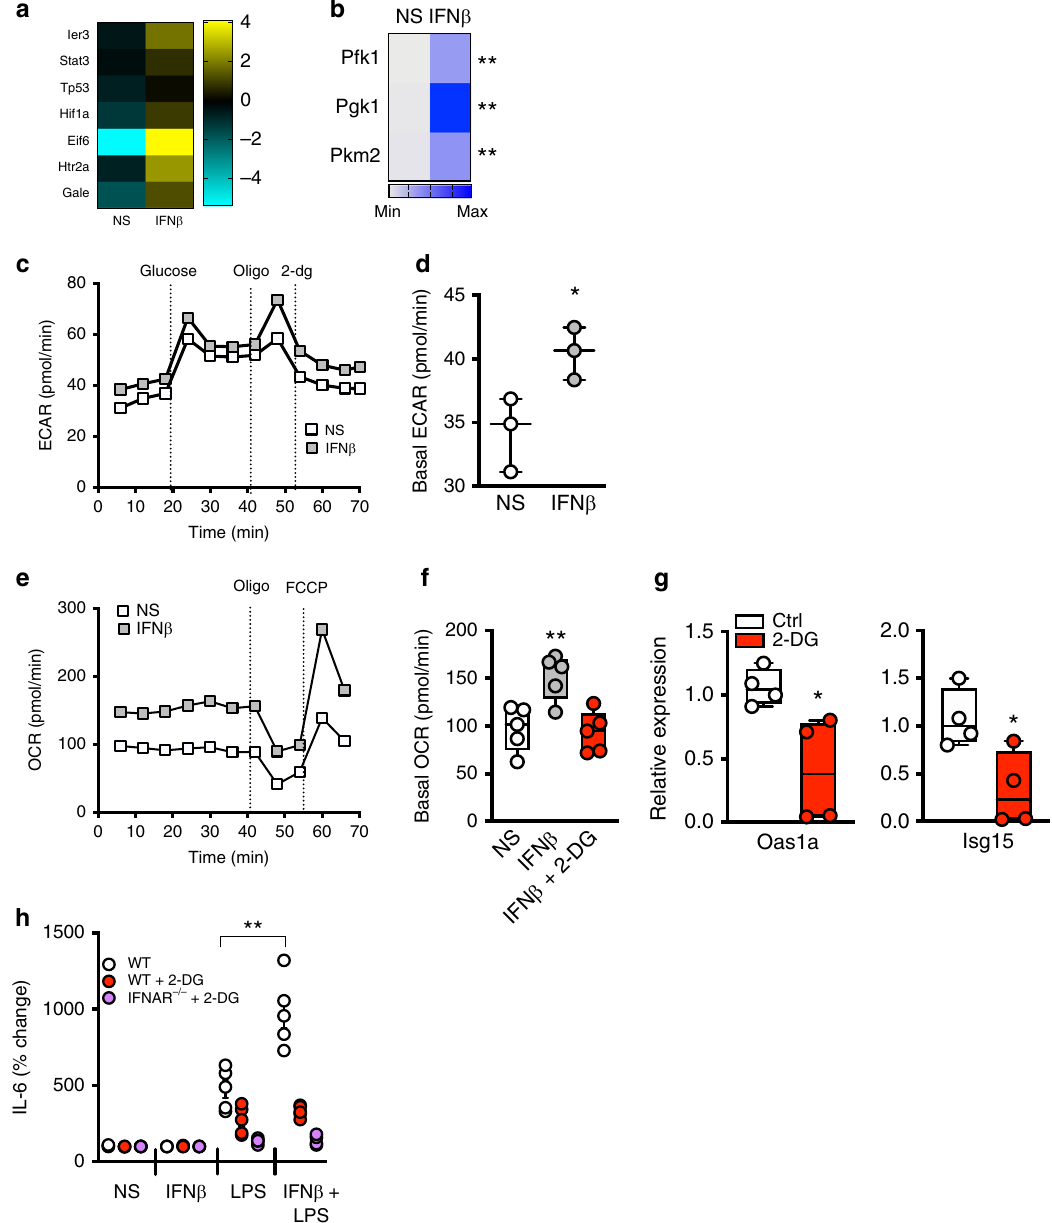
Fig. 3 IFN β modi fi es glycolysis-associated in fl ammatory vigor in adipocytes. a Differential expression of representative genes in pathways associated with regulation of glycolysis in adipocytes from RNA-seq analysis. b WT adipocytes were treated in the presence or absence of IFN β (250 U/ml) and mRNA expression of indicated glycolytic pathway-associated genes measured by qPCR, relative expression compared to NS. c − f Adipocyte cellular bioenergetics as determined by Seahorse XF96 analyzer with sequential injection of glucose (2 mM), oligomycin (2 µ g/ml), 2-Deoxy- D -glucose (2-DG, 10 mM), or FCCP [1 mM] as indicated. c Mean extracellular acidi fi cation rate (ECAR). d Basal ECAR. e Mean oxygen consumption rate (OCR). f Basal OCR in the presence or absence of pretreatment with 2-DG (2 mM). g IFN β (250 U/ml)-treated adipocyte expression of indicated type I IFN axis genes measured by qPCR in the presence or absence of 2-DG (2 mM), relative expression to ctrl. h IL-6 protein levels in adipocyte supernatant quanti fi ed by ELISA; % change over NS. a A single experiment, n = 2/condition. b Representative of three independent experiments, n = 3/condition. c − f Representative of three independent experiments, n = 3 − 5/condition. g Representative of three independent experiments, n = 3 − 4/condition. h Data combined from two independent experiments, n = 3 − 5/condition. c − h For box plots, the midline represents the mean, boxes represent the interquartile range and whiskers show the full range of values. In line graphs data represent mean ± SEM. b , d , f − h Unpaired two-tailed Student ’ s t test. * P < 0.05, ** P < 0.01. Source data are provided as a Source data fi However, genetic modulation of IFNAR signaling altered WAT resistance 29 . Despite increased eWAT size, lack of IFNAR distribution (i.e. increased eWAT mass (Fig. 4d), decreased signaling correlated with reduced eWAT total immune cell inguinal (Fig. 4e) and perirenal WAT mass (Fig. 4f)). in fi ltration (CD45 + ) and speci fi cally with diminished numbers Progressive decline in eWAT is associated with increased of in fi ltrating T cells (CD3 + CD4 + and CD3 + CD8 + ) and B cells (CD11c − B220 + ) (Fig. 4g; Supplementary Fig. 7; Supplementary adipocyte death, enhanced in fl ammation and total body insulin